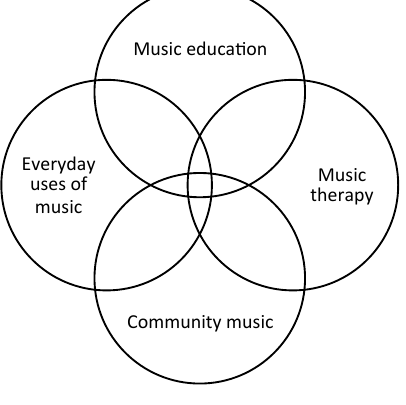
Fig.1 A conceptual framework for music, health and wellbeing. From MacDonald, Kreutz, and Mitchell (2012: 8)